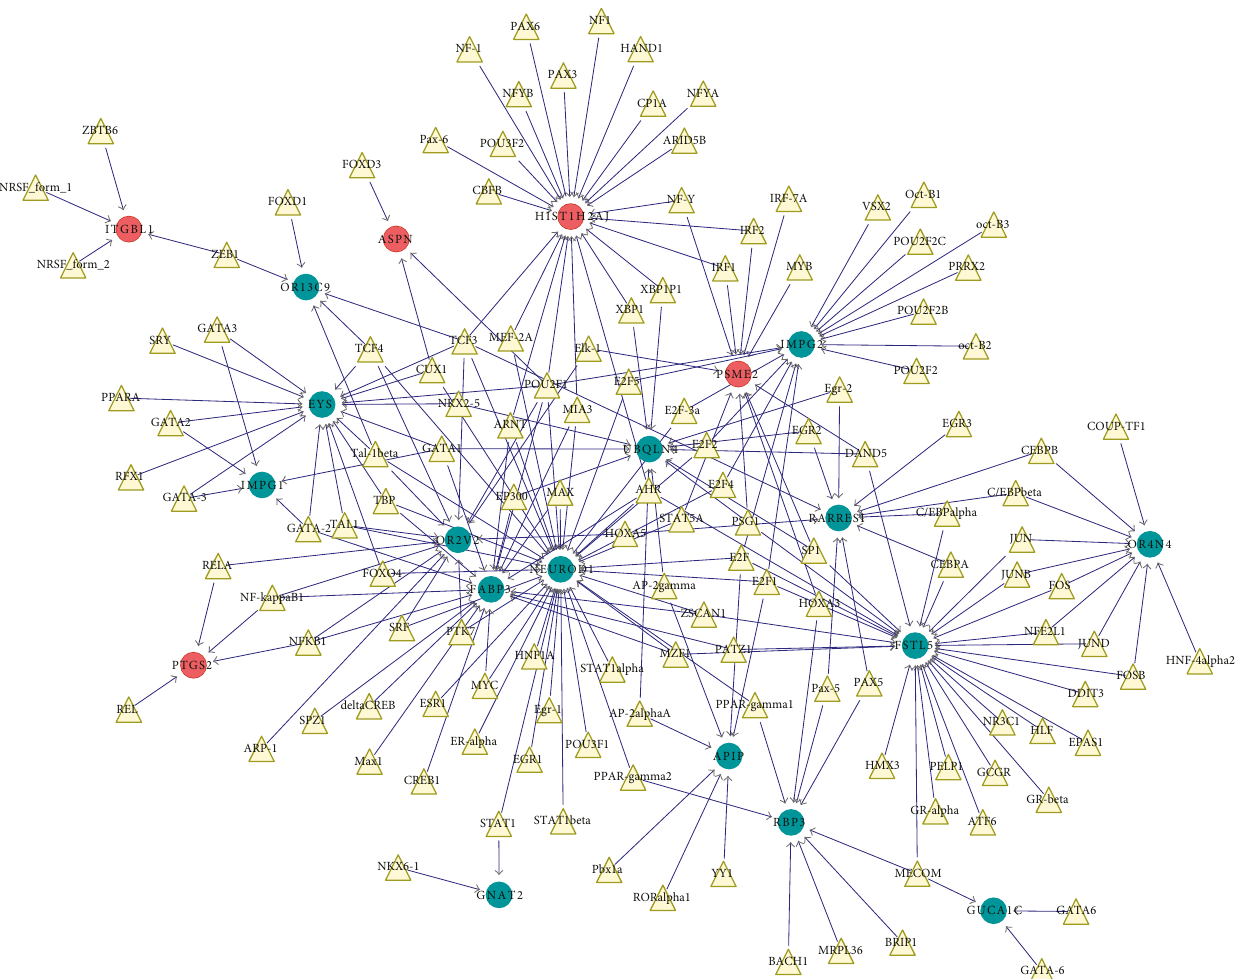
Figure 3: Transcription factor (TF) di ff erentially expressed genes (DEG) network. Red nodes represent upregulated DEGs; green nodes represent downregulated DEGs; yellow triangles represent TFs; arrowed lines represent the regulatory